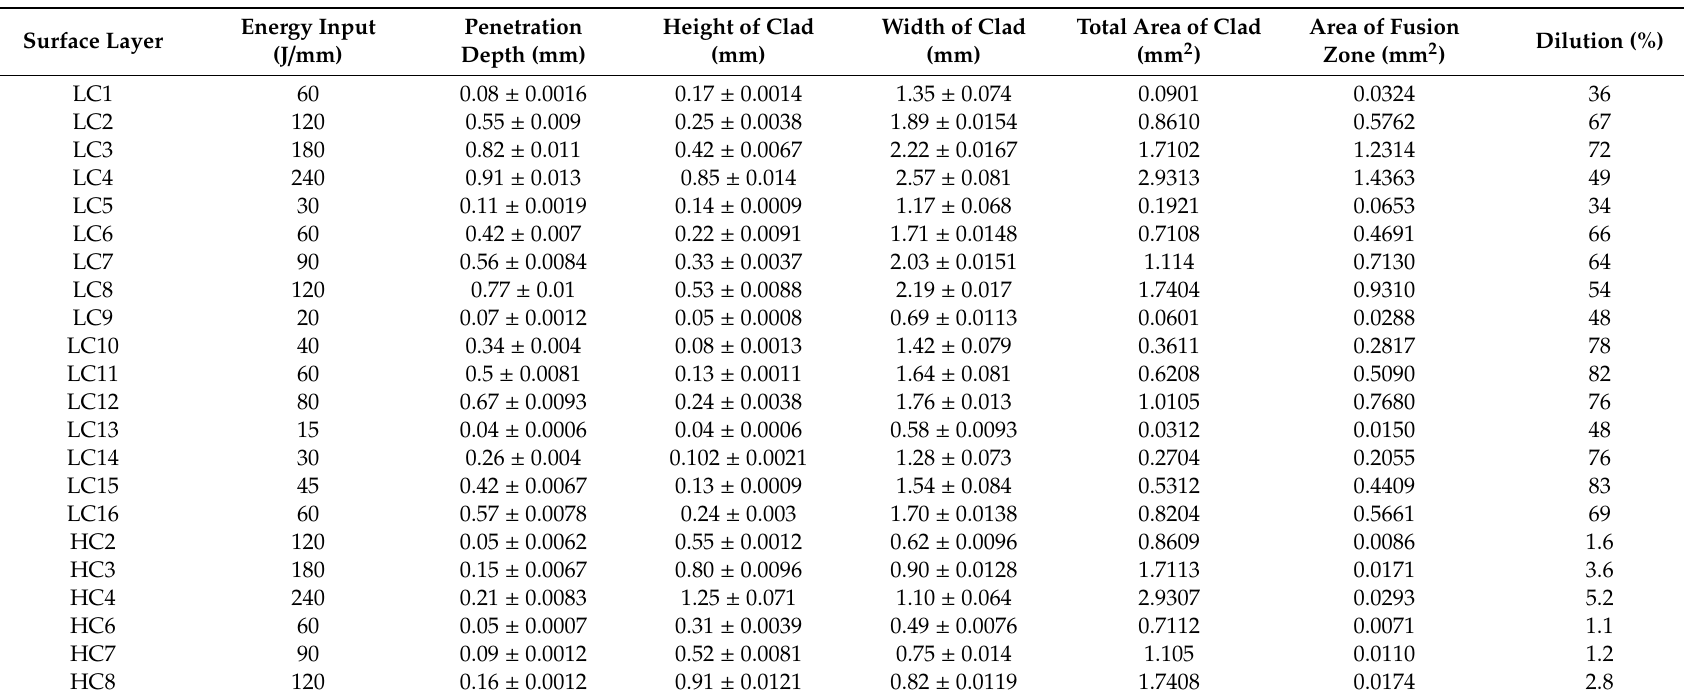
Table 4. Results of geometry determined for the stringer beads produced by the laser deposition of experimental Fe-based metallic powder at free cooling conditions (conventional laser cladding) and forced cooling by liquid nitrogen bath under cryogenic conditions (hybrid laser deposition process), as shown in Figures